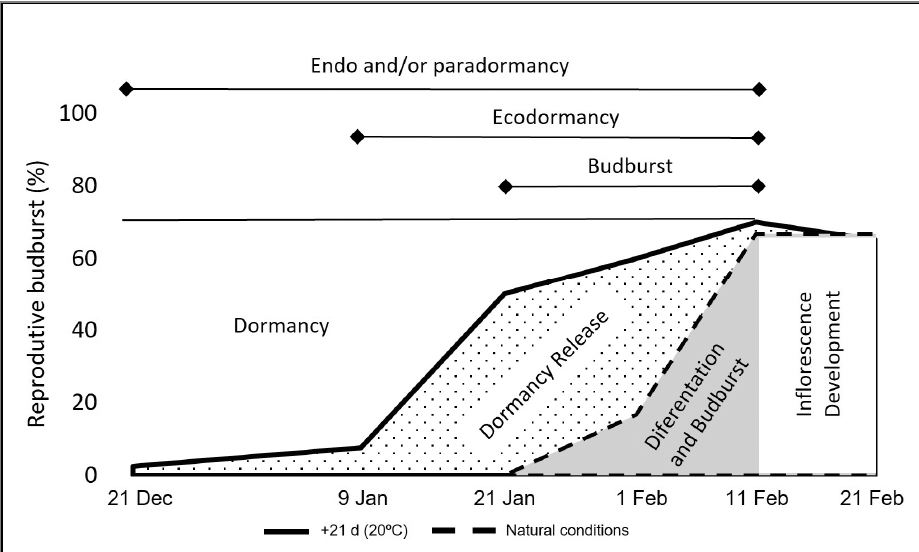
Figure 6. Interpretive scheme for the progression of dormancy phases in the bud population under the study conditions, using OFF tree data. Dates of dormancy release, indicated by reproductive budburst after 21 days forcing at 20 °C, are shown by the solid line. Dates of budburst under natural conditions, for which the buds had to first achieve release from dormancy and then overcome ecodormancy restrictions, are shown by the slashed line. The dormancy periods according to [6] are shown by horizontal lines in the upper part of the